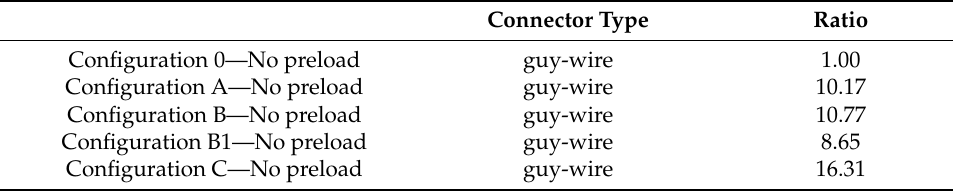
Table 9. Comparison of all the configurations.